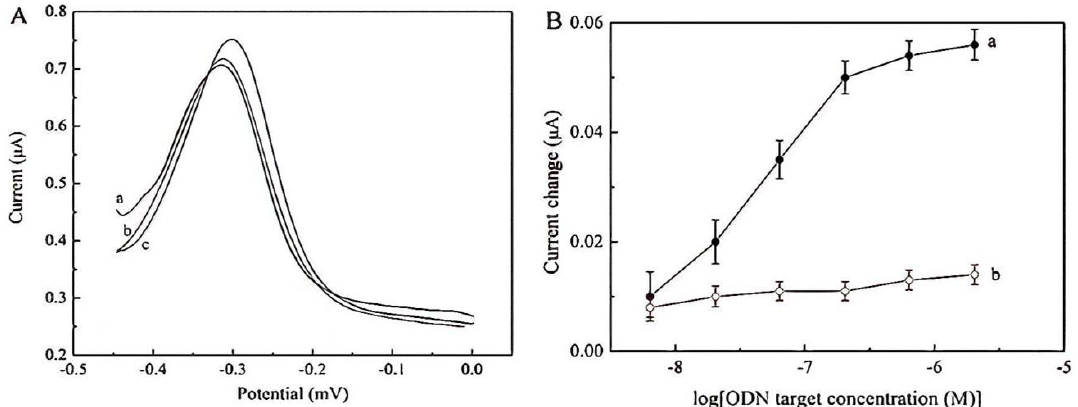
Figure 5. ( A ) Differential pulse voltammograms of accumulated PMT-MB on modified gold electrodes. (a): ssODN modified; (b): after incubation with 0.204 _M of noncomplementary ODN target; (c) after incubation with 0.204_M of complementary ODN target. ( B ) The current change in DPV response of PMT-MB with the concentration of complementary ODN target (a) and non-complementary ODN (b). PMT-MB was accumulated for 25 min in 5 mM phosphate buffer solution containing 0.032 mg/mL of PMT-MB. DPV was measured in blank phosphate buffer [53].